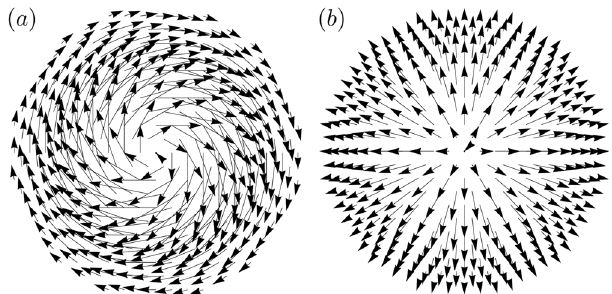
Fig. 4 Collective optical excitations with singular-like defects. The real component of the atomic polarisation density P ( r ) exhibits ( a ) an azimuthal or ( b ) radial point vortex in a steady-state response to the incident light fi eld of Eq. (14) that mediates dipole-dipole interactions between the atoms in an N = 313 triangular array with circular boundaries and spacing a / λ = 0.5. The imaginary part of P ( r ) is approximately zero. The beam width w 0 / λ = 2.77, phase φ = 0, and laser frequency detuning from the atomic resonance Δ / γ = 0.90 for a , or φ = π and Δ / γ = 0.89 for b